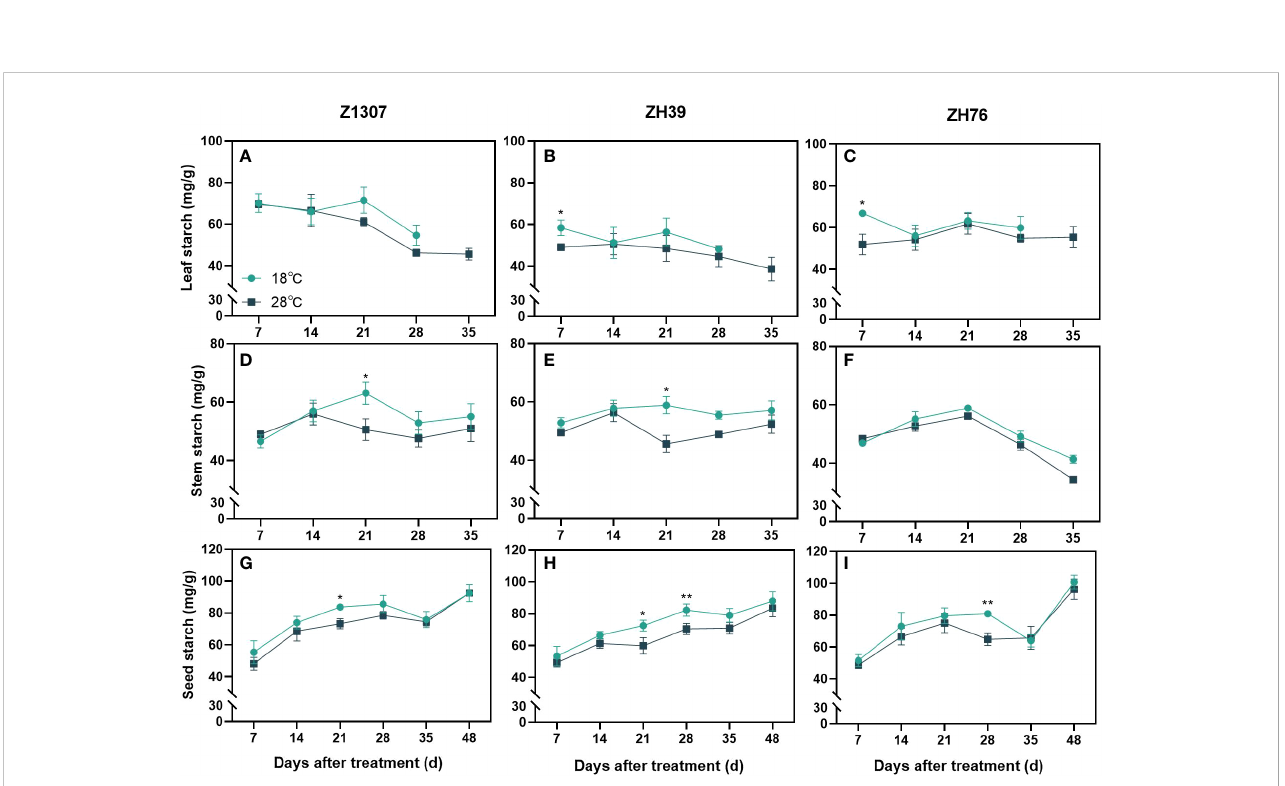
FIGURE 6 Effect of high night temperature on starch content in soybean leaf, stem and seed. The light blue/ black blue line indicates the 18 ℃ /28 ℃ treatment. The broken lines respect the dynamic changes of the starch content of leaf (A-C) , stem (D-F) and seed (G-I) with the days of different high night temperature treatments for the three varieties of Z1307, ZH39 and ZH76. Values shown are means ± SE from three biological replicates. (*, P < 0.05; **, P < 0.01).